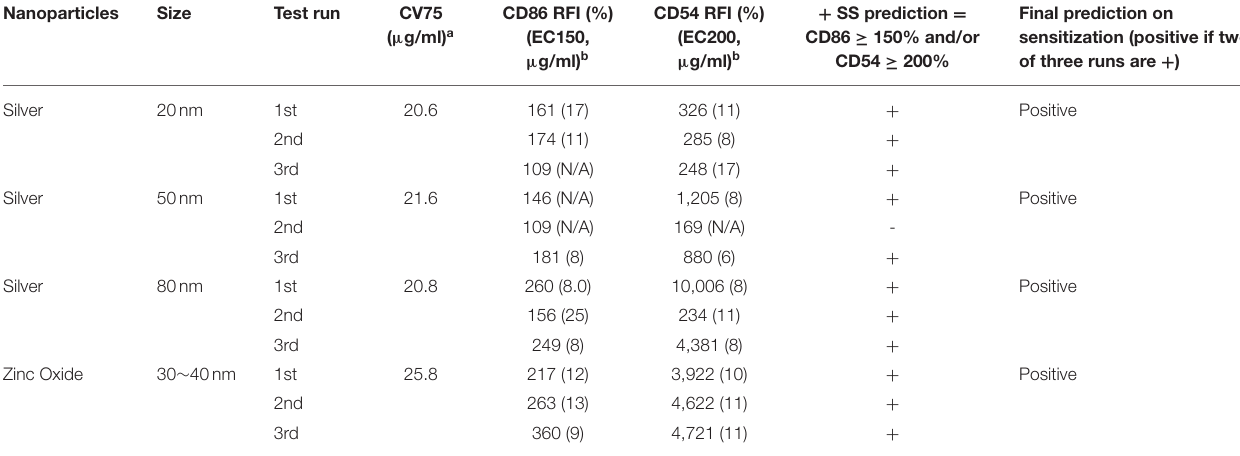
TABLE 2 | Prediction of the SS potency of silver and zinc oxide nanoparticles by h-CLAT assay.